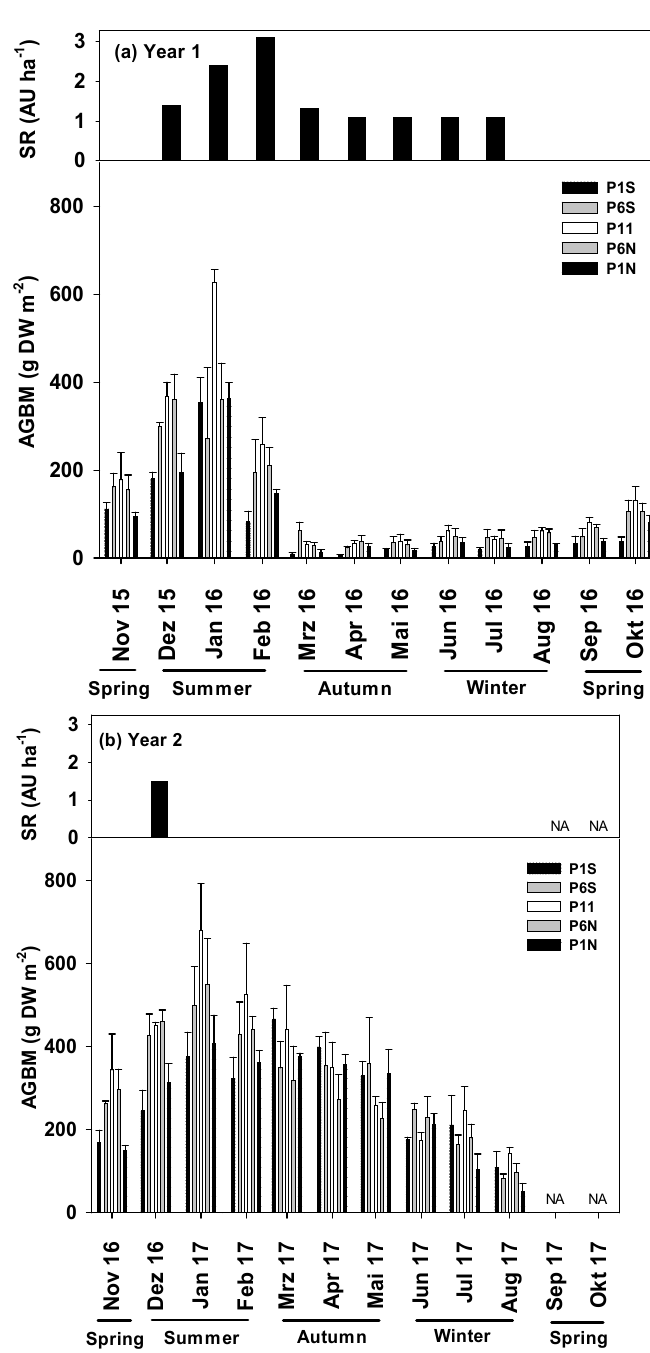
Figure 6. Monthly stocking rate (AU ha − 1 ; SR = stocking rate, AU = animal unit = 450 kg) and mean monthly aboveground green grass biomass (AGBM) (g DW m − 2 ) for each sample point between the tree rows for ( a ) year 1: November 2015–October 2016 and ( b ) year 2 November 2016–August 2017. P1S: 1 m and P6S: 6 m from southern row. P1N: 1 m and P6N: 6 m from northern row. P11: 11 m from southern and northern row respectively. Bars represent standard errors.